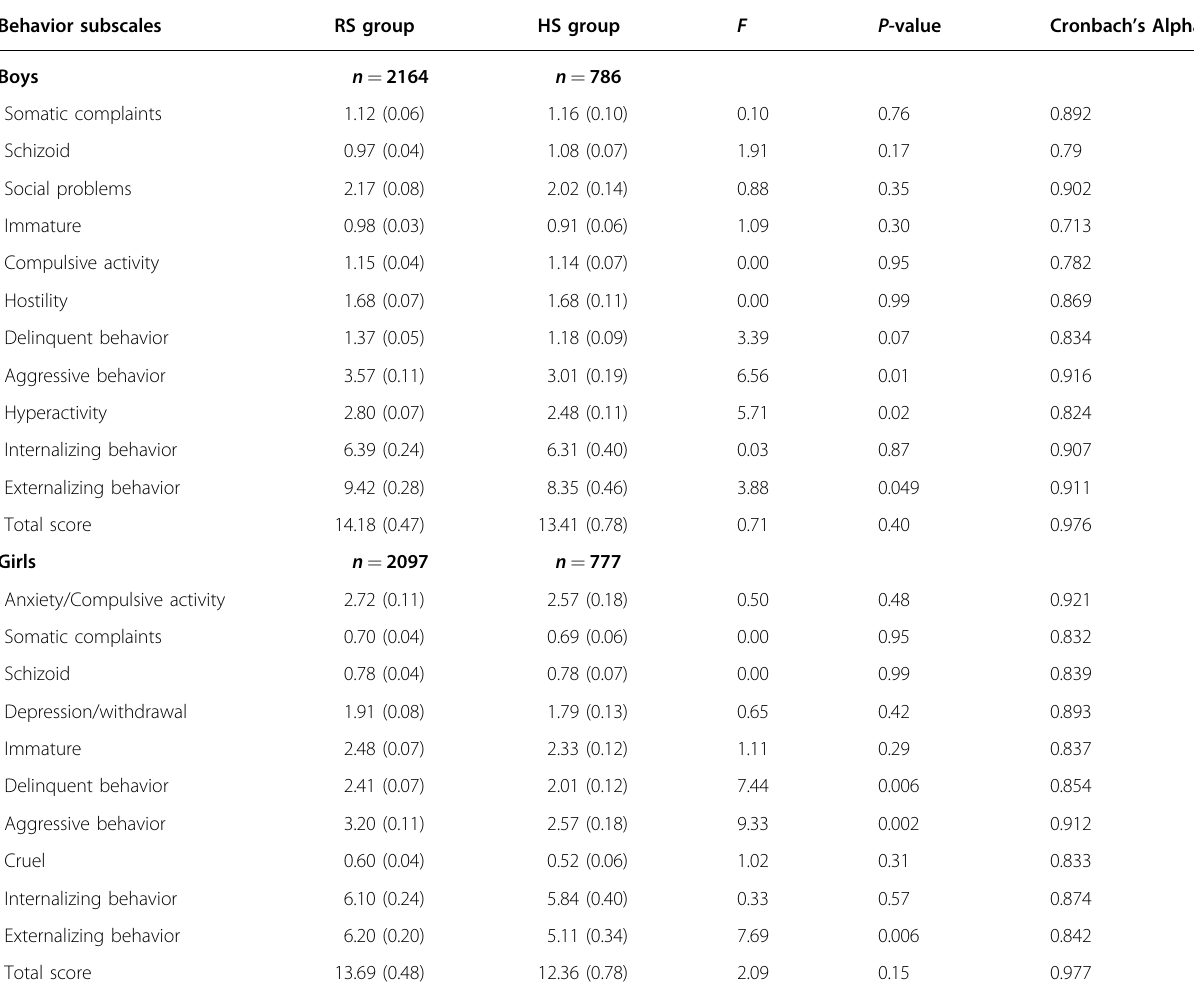
Table 3 Comparison of CBCL scores between RS group and HS group (boys and girls of 12 – 16 years) during COVID-19. Behavior subscales RS